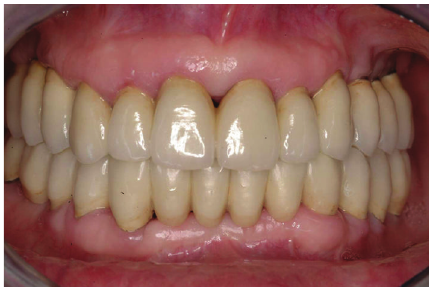
Figure 37: Final delivery of the prosthetic reconstruction (May 2002). From a functional standpoint, the objective of restoring good occlusal stability was achieved.